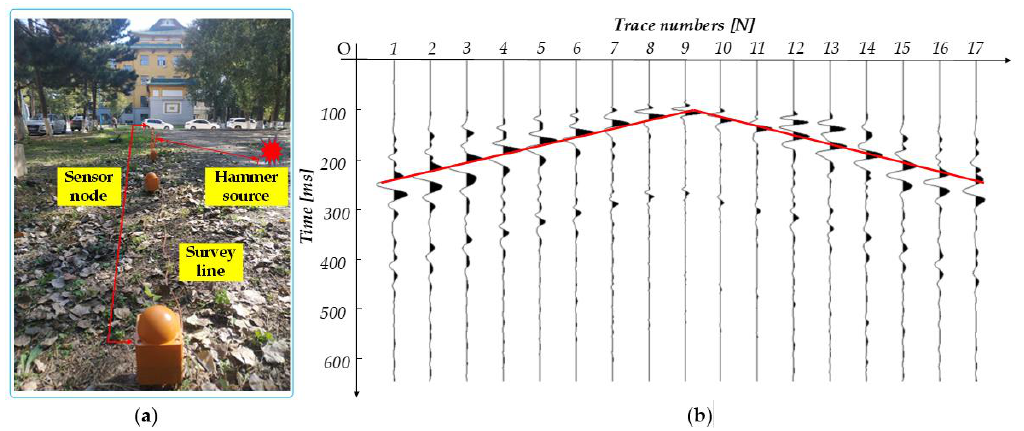
Figure 15. Field measurement with the sensor nodes in equal intervals. ( a ) The sensor nodes are deployed in second field experiment and ( b ) the waveform of the recorded seismic data.